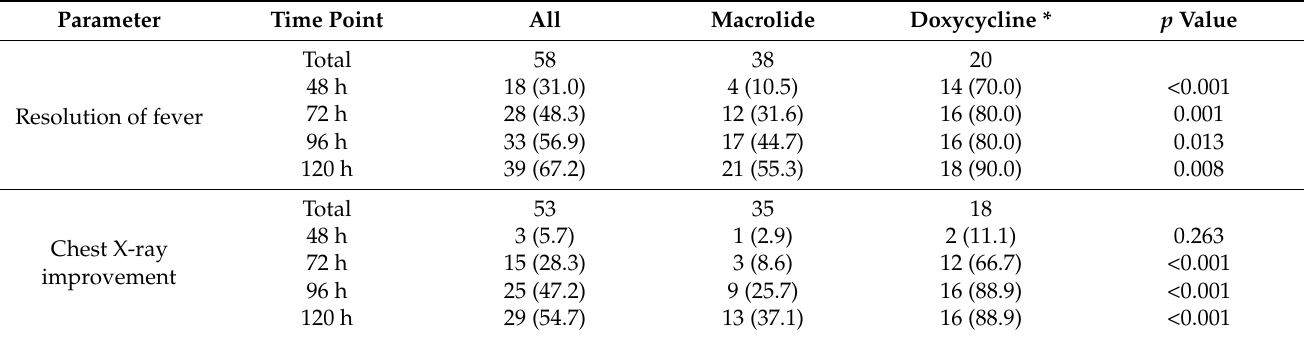
Table 4. Cumulative incidence of fever or chest X-ray improvement after antibiotic initiation in macrolide-resistant Mycoplasma pneumoniae pneumonia.